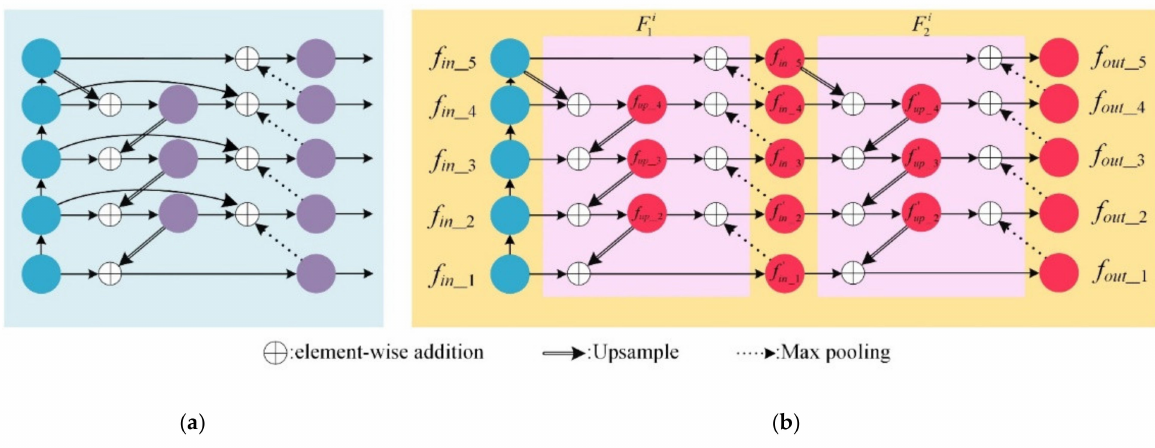
Figure 2. BiFPN and our DFR network. ( a ) BiFPN. The structure of BiFPN is the optimization of FPN and PANet. It utilizes cross-scale connection and weighted feature fusion to extract and fuse features of different resolutions base on the EfficientNet backbone [23]. ( b ) DFR network. We stack two BiFPN layers of bottom-up and top-down structures and then combine the structure with ResNet50, which is widely used in the object detection process to achieve a sound performance of feature extraction and fusion. The blue circles on the left are feature maps extracted by ResNet50, and the remaining on the right is the Double FPN structure we proposed. “ ⊕ ” represents the fusion process. The sign of double lines with an arrow “ ⇒ ” represents the operation of upsampling which can resize the feature map twice as large as the original. The dashed arrow means the operation of max pooling, which can resize the feature map half of the